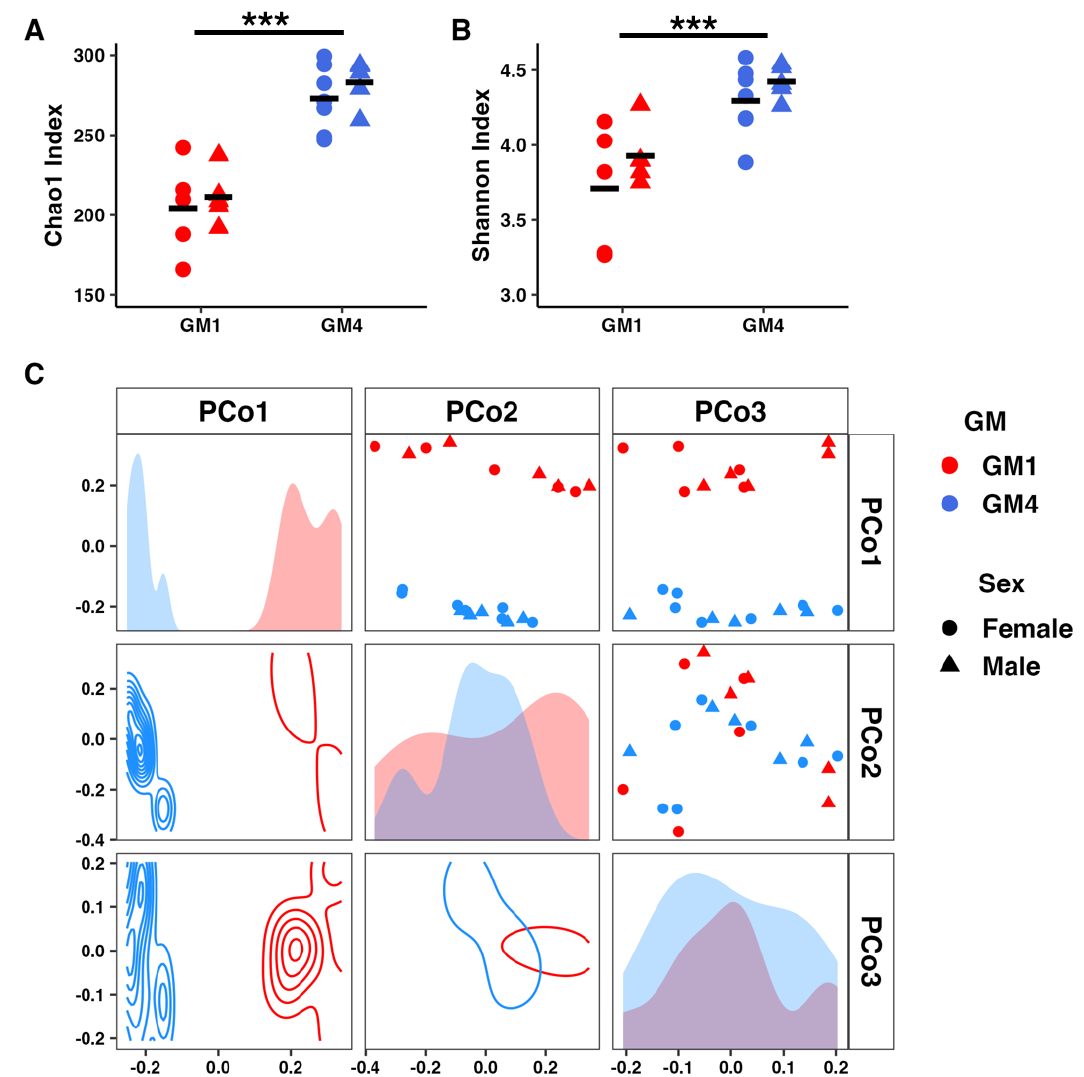
Figure 5. Dot plots showing detected richness ( A ) and Shannon diversity ( B ) across the cages used in the intake study, and principal coordinate analysis (PCoA) matrix depicting microbial community structure along the first three principal coordinates using Bray–Curtis distances ( C ). Dot plots depict individual samples along two axes. Density plots depict sample distribution along two axes. Histograms depict sample distribution along a single axis. Triple asterisk indicates p < 0.001.